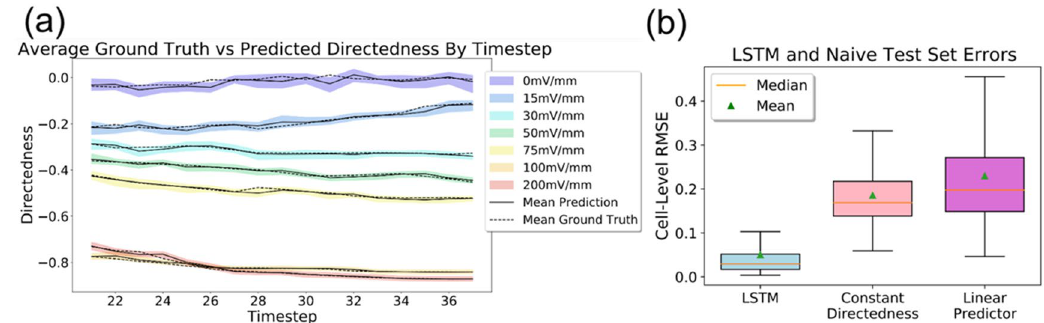
Figure 3. ( a ) Average predicted directedness and distribution across 50 models compared to ground truth measurements at each EF. A timestep unit is 5 min (the interval at which images were taken). The first 19 time steps are used to initiate predictions. ( b ) Comparison of LSTM model to naïve predictors. Root mean square error (RMSE) values computed based on predicted directedness and measured directedness. The boxes represent the middle 50% of error values and the whiskers extend to the minimum and maximum error values.